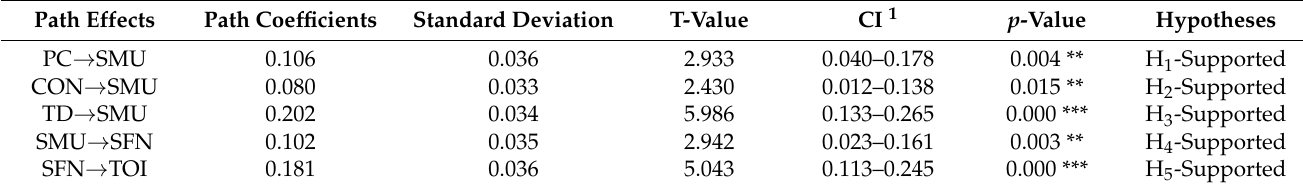
Table 4. Path effects computed in